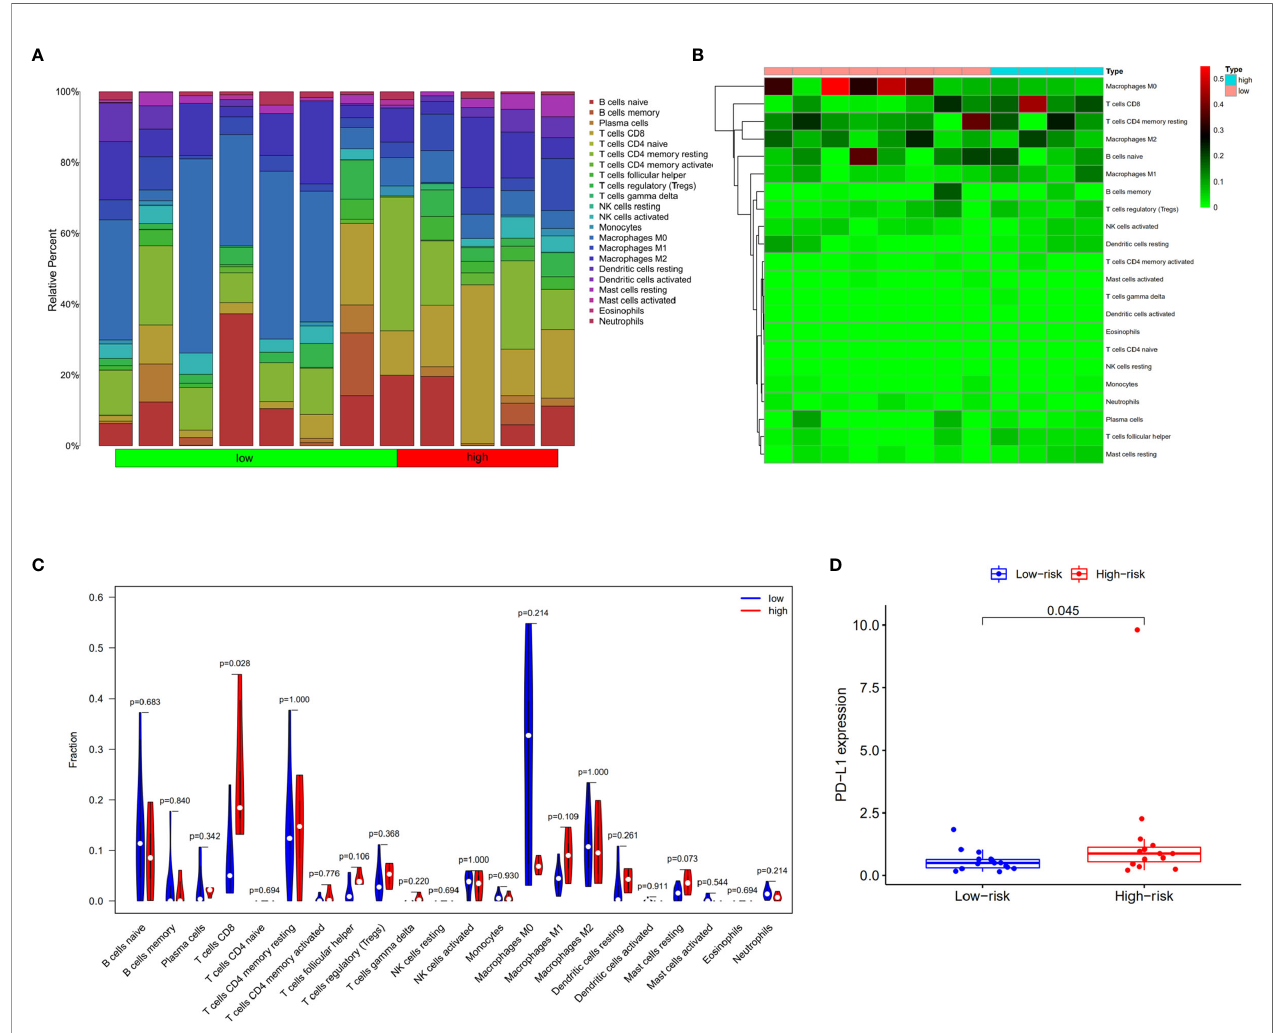
FIGURE 9 | In fi ltrating immune cells in cholangiocarcinoma. (A) Bar plot showing the proportion of 22 kinds of immune cells in patients with CIBERSORT value < 0.05. (B) Heat map showing the proportion of 22 types of immune cells in high- and low-risk groups. (C) Vioplot showing the compression of each immune cell type between high- and low-risk groups. (D) Bar plot of PD-L1 expression in high- and low-risk